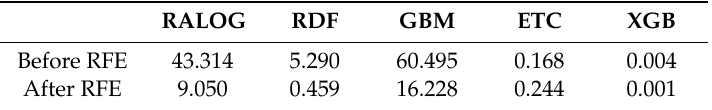
Table 5. Training time (ms) of ensemble